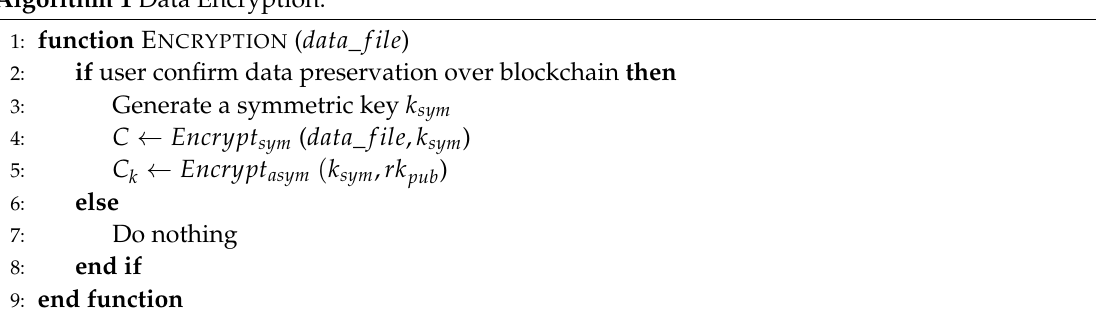
Algorithm 1 Data Encryption.